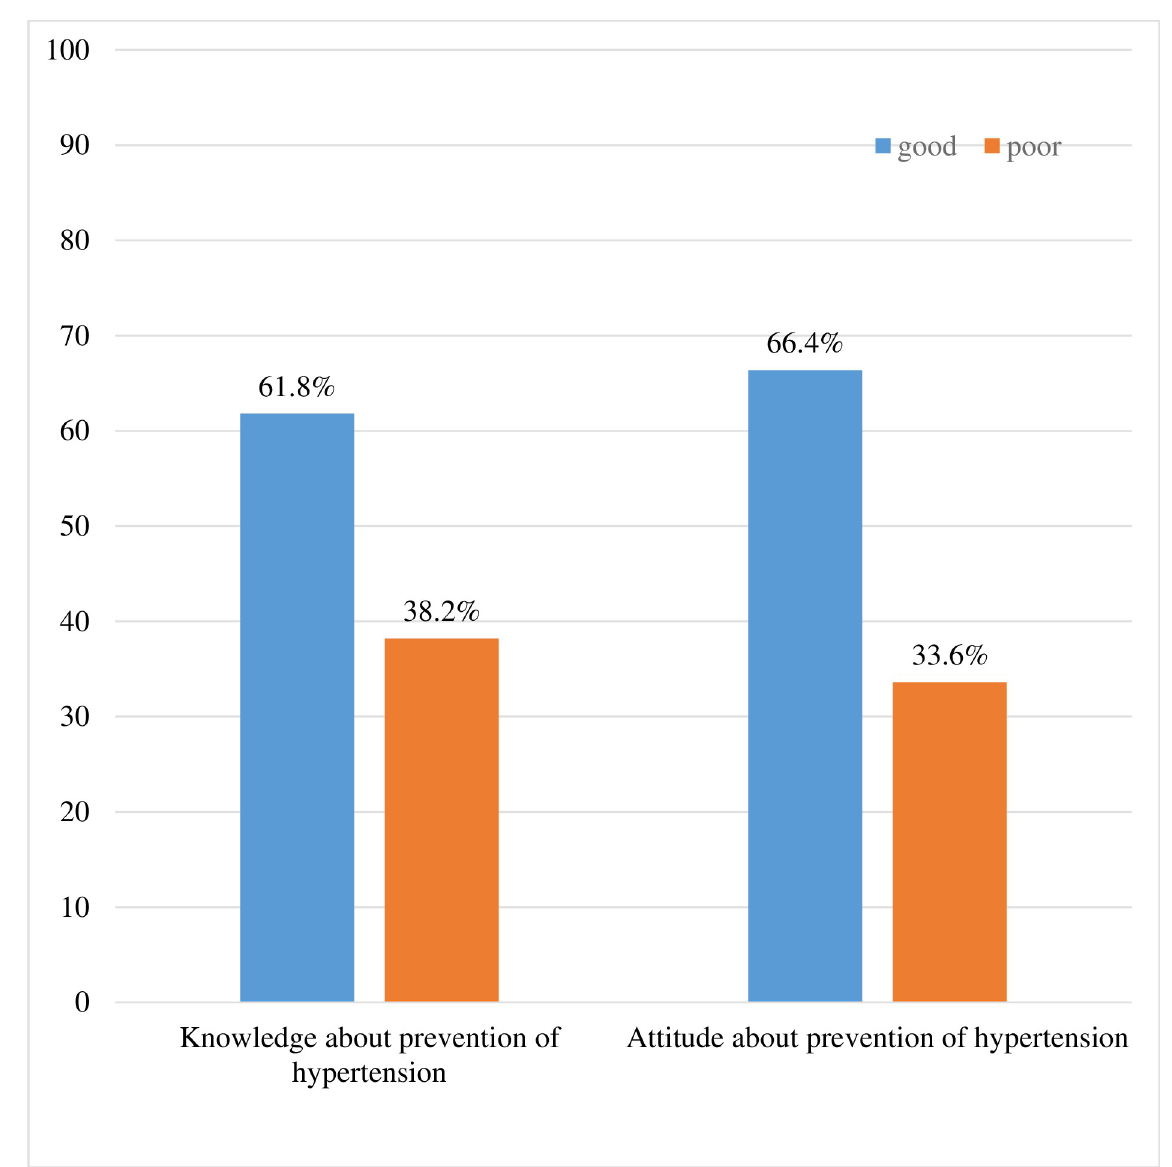
Fig 1. Knowledge and attitude of clients receiving HAART towards prevention of hypertension, Southern Ethiopia, January 20-March 20, 2020.